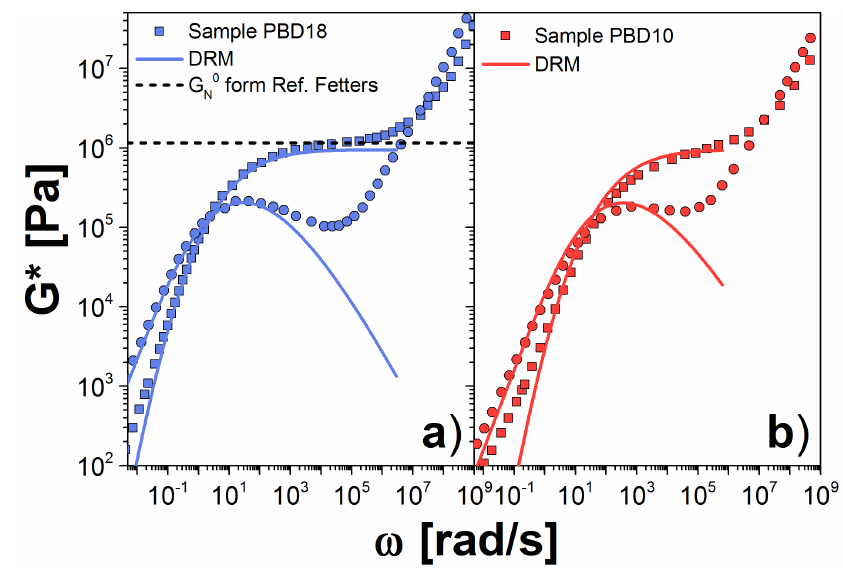
Figure 3. Dynamic moduli for PBD samples: ( a ) PBD18; and ( b ) PBD10 at 30 ◦ C. Symbols are the experimental results reported in Ref. [23]; solid lines are our theoretical prediction using the DRM; and the dashed line is the plateau modulus reported in Ref. [24]. Squares are storage modulus, G (cid:48) , and circles are loss modulus, G (cid:48)(cid:48) . Our estimations for the parameters G 0 and τ 0 are listed in Table 2. N In panel ( b ), we used the G 0 obtained for the PBD18 N